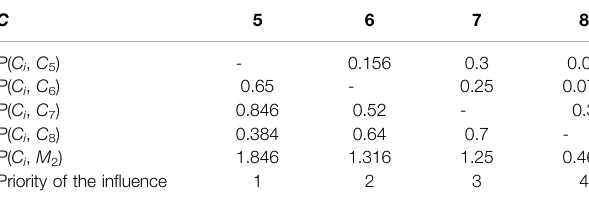
TABLE 2 | The change impact degrees of parts within M 2 .